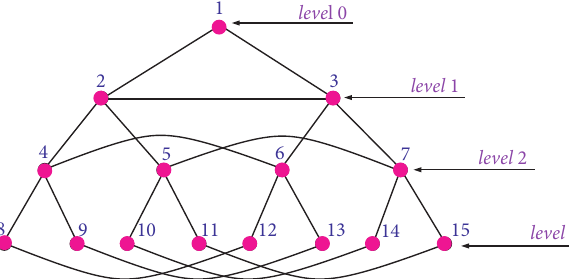
Figure 1: An illustration of the hypertree CBT ( t ) for t � 3 levels [28].